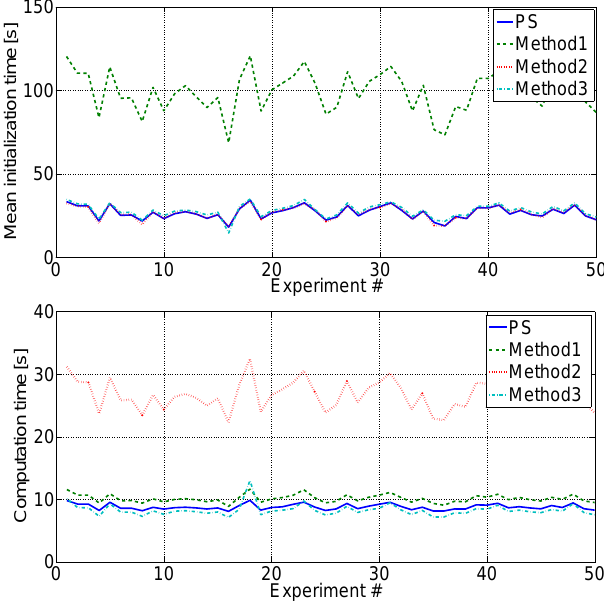
Method2 , which uses IDL = 2 and Rate2 during the whole experiment, obtained the lowest map and worst map and robot errors. Method3 and the proposed method obtained intermediate map and